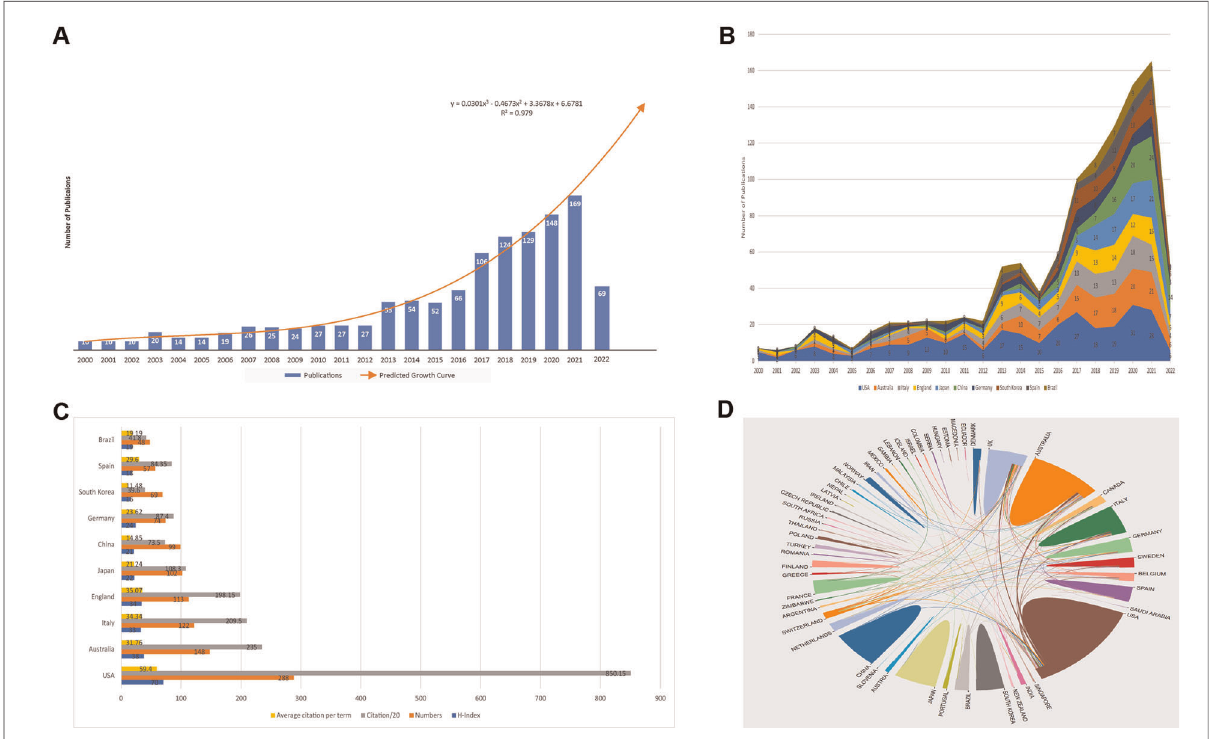
FIGURE 2 Analysis of general information and countries of publications. ( A ) The number of publications about sarcopenia and hip fractures in older patients from 2000 to 2022; ( B ) the number of publications of the top 10 countries with the largest number of studies from 200 to 2022; ( C ) the number of publications and citations, H-index, average citations per term of the top 10 most in fl uential countries; ( D ) international cooperation among different countries or